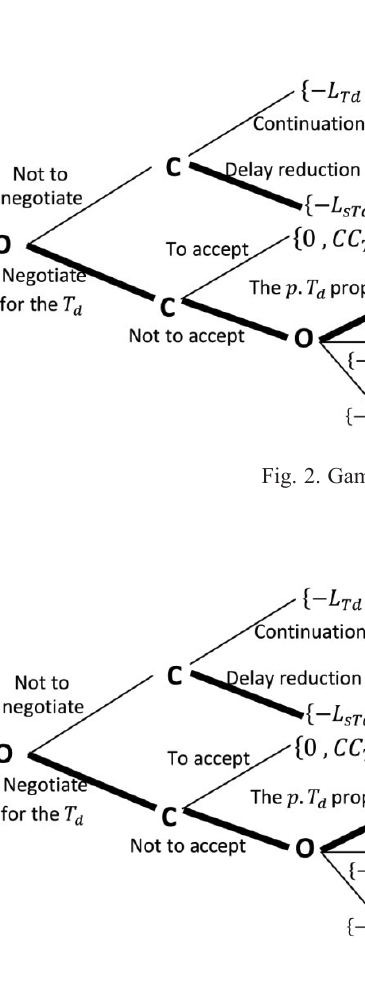
Fig. 3. Game tree for resolution 2 – form